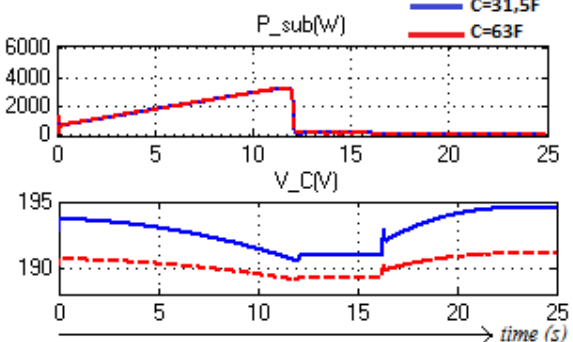
Fig. 12. Simulation diagrams for V SC = 193.67 V when C = 31.5 F and V SC = 190.62 V when C = 63 F.